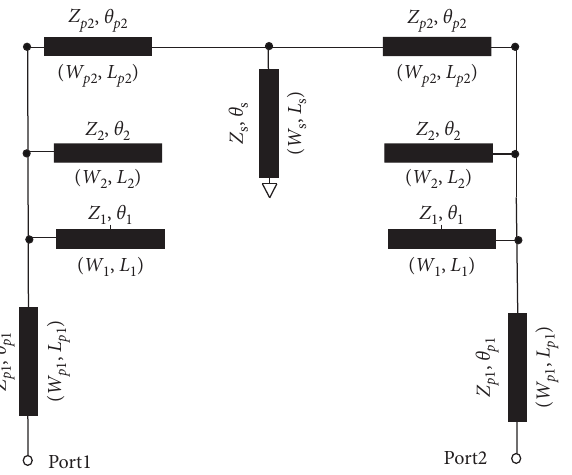
Figure 7: *e quad-band equivalent transmission line model for the proposed BPF.